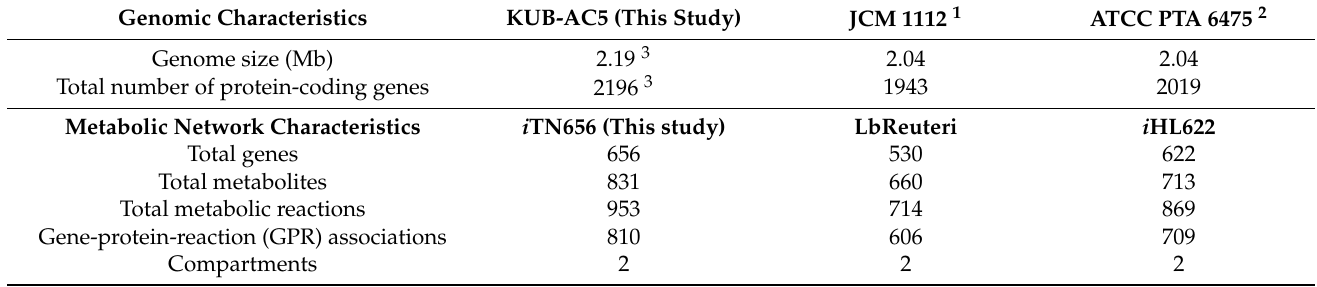
Table 1. Comparative characteristics of genomes towards metabolic networks of different strains of L.